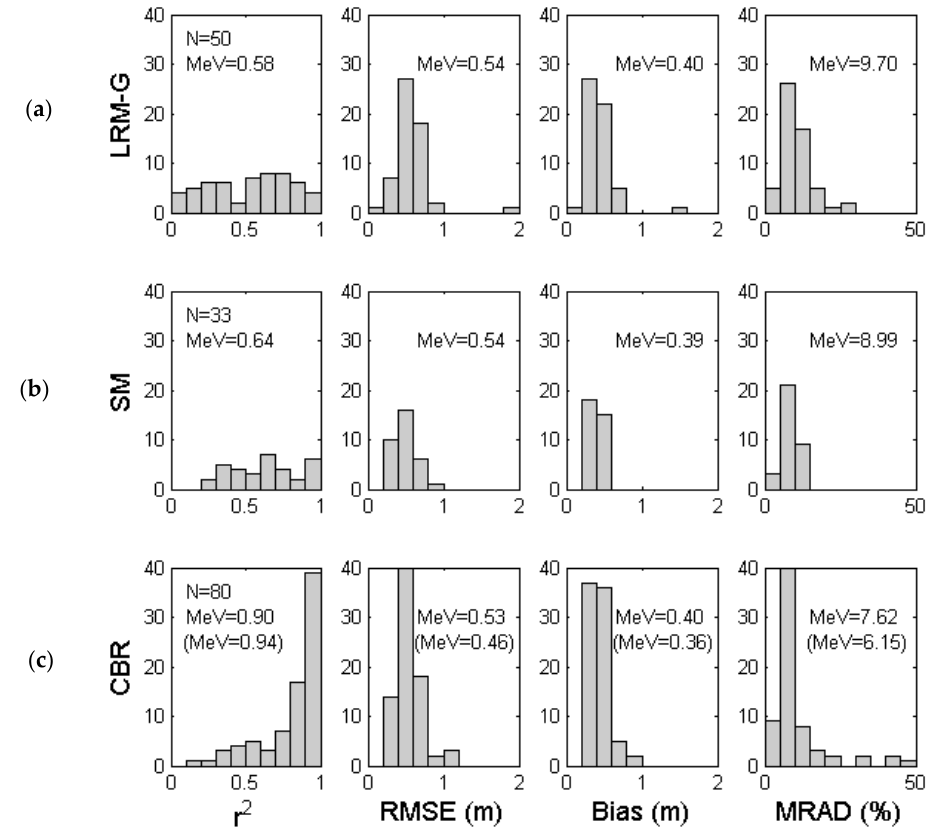
Figure 7. Distribution of performance of empirical SDB approaches for ( a ) the linear regression model using the log-transformed G-band (LRM-G); ( b ) the switching algorithm using LRM-G and LRM-R (SM); and ( c ) the cluster-based regression model (CBR). Performance is quantified using the coefficient of determination (r 2 ), the root mean square error (RMSE), the bias (Bias), and the mean relative absolute difference (MRAD). N is the number of satellite images; MeV is the median value. The MeV value between parentheses is calculated using the 33 best satellite scenes.